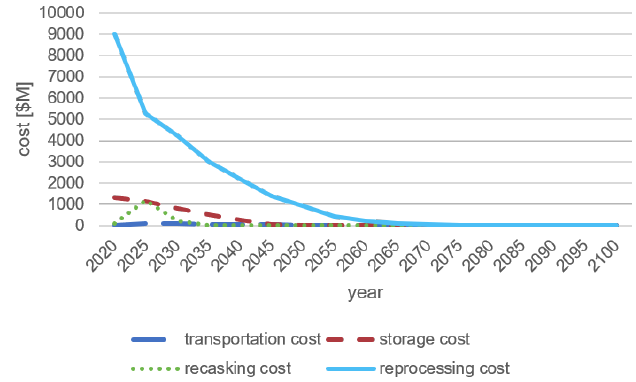
Figure 8. Distribution of costs over time in the Yuc_reproc scenario. Source: own